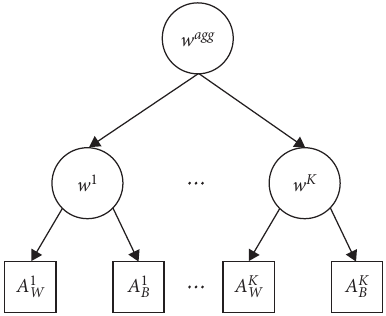
Figure 1: Probabilistic hierarchical model of the Bayesian